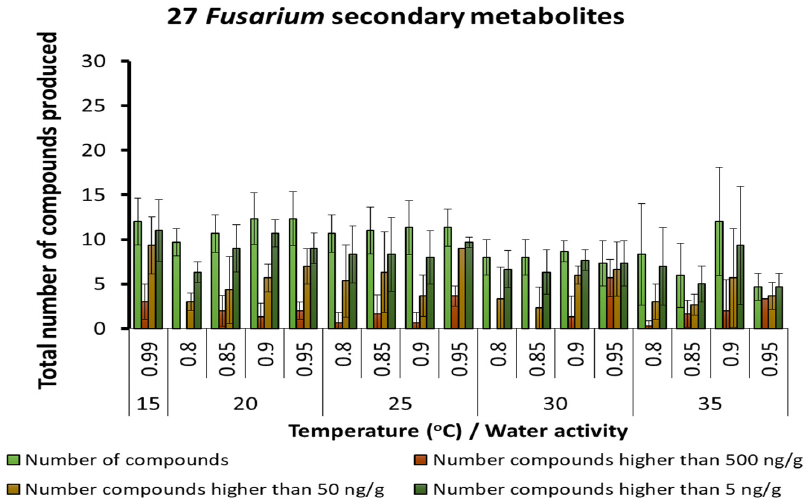
Figure 5. Summary of the predominant secondary metabolites of Fusarium species detected in maize grain stored under different temperature × water activity conditions. Bars represent the Standard Error of the mean. Table 4. Detailed list of the quantified major secondary metabolites of Fusarium species detected in the maize under different temperature × water activity conditions. The conditions highlighted in green (low concentrations), yellow (medium concentrations) and red (highest concentrations) were found. LOD: Limit of Detection.